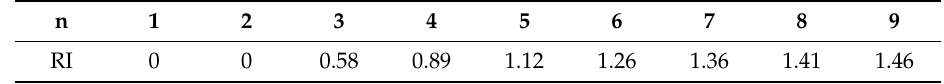
Table 2. Random indices